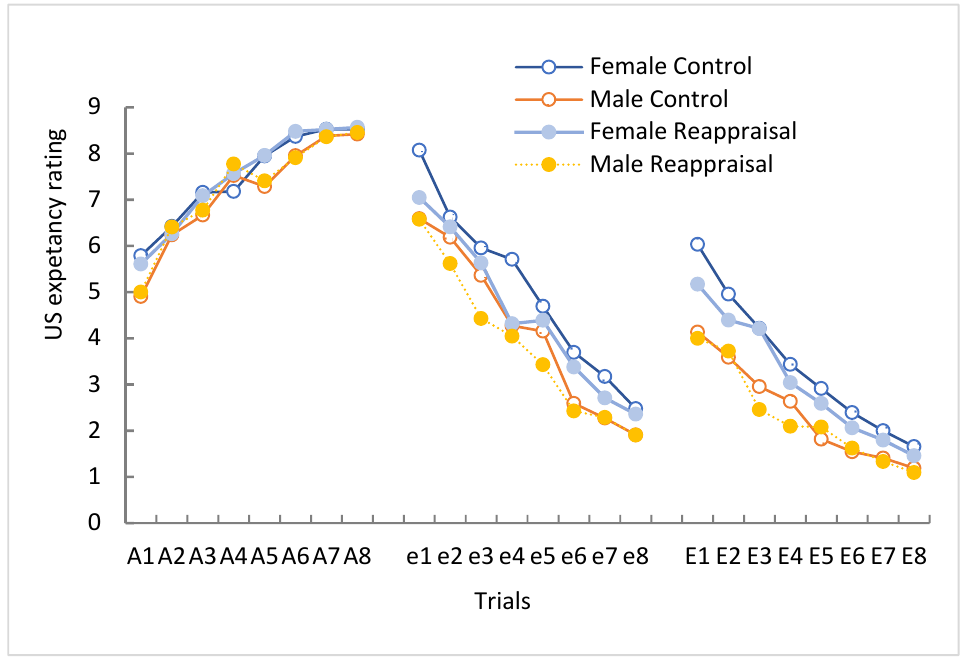
Figure 2. Mean expectancy rating of CS+. The US-expectancy of the CS+ during acquisition (A1 – A8), extinction (e1 – e8) and re-extinction (E1 – E8) for the devaluation and control groups. A trial *gender *group repeated measures ANOVA of CS+ US-expectancy ratings showed significant gender main effect (F(1,1) = 46.97, p = 0.000, η 2 p = 0.476) and marginal significant group main effect in group main effect (F(1,1) = 3.867, p = 0.050, η 2 p = 0.088) during re-extinction stage. Respective univariate ANOVA of CS+ US-expectancy rating of different trials (E1–E8) in men and women showed significant difference between control group and reappraisal group just in female (F female (1,502) = 4.022, p = 0.042, η 2 p = 0.112; F male (1,502) = 0.034, p = 0.95, η 2 p = 0.002). So, compared with women, the CS+